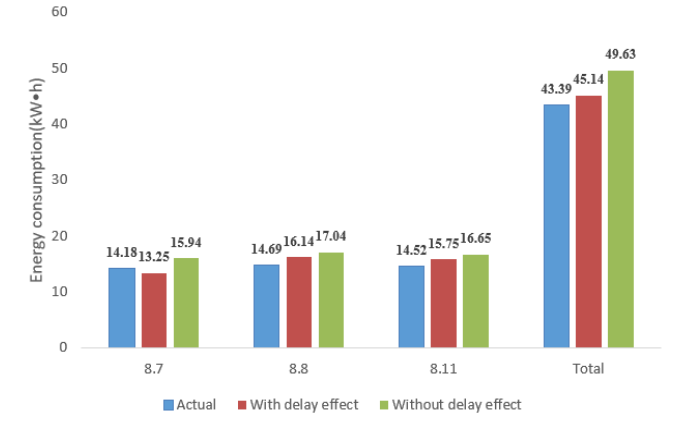
Figure 8. Comparison of simulated energy consumption and actual energy consumption of heat pump units.